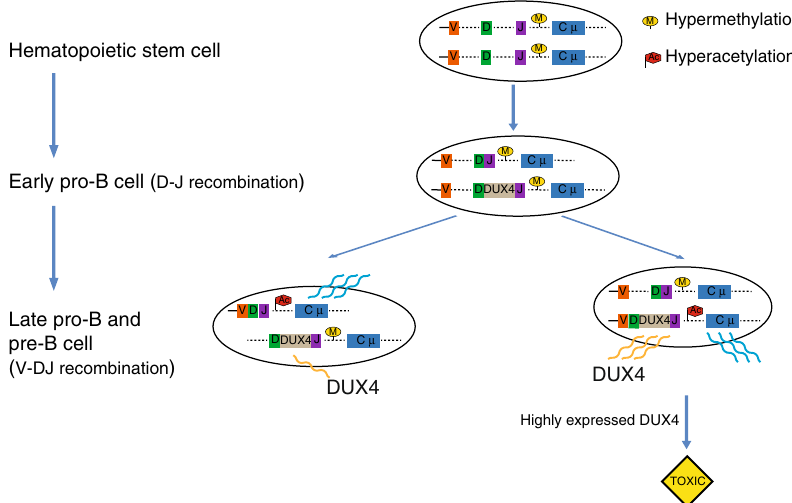
Fig. 5 A proposed model for the interplay between IGH - DUX4 translocation and IGH allelic exclusion during B-cell